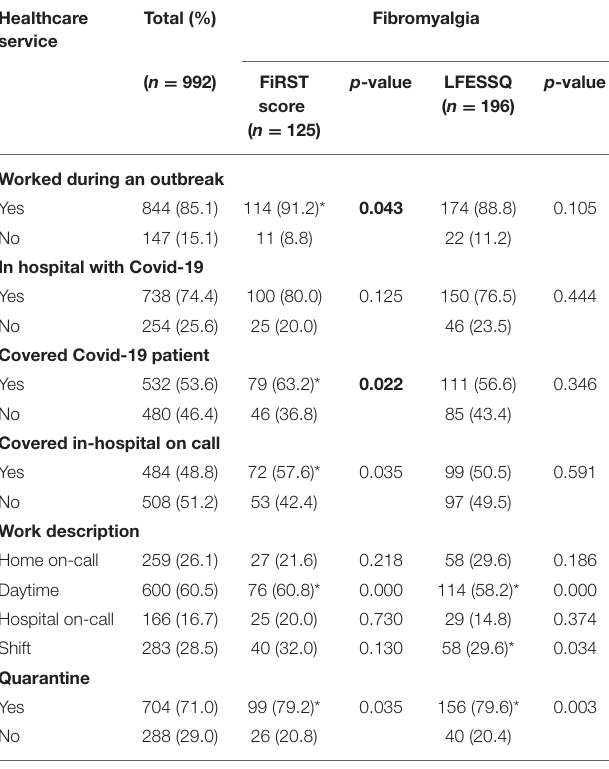
TABLE 4 | Relationship of fibromyalgia with the healthcare service status of the participants during an outbreak ( n = 992). Healthcare